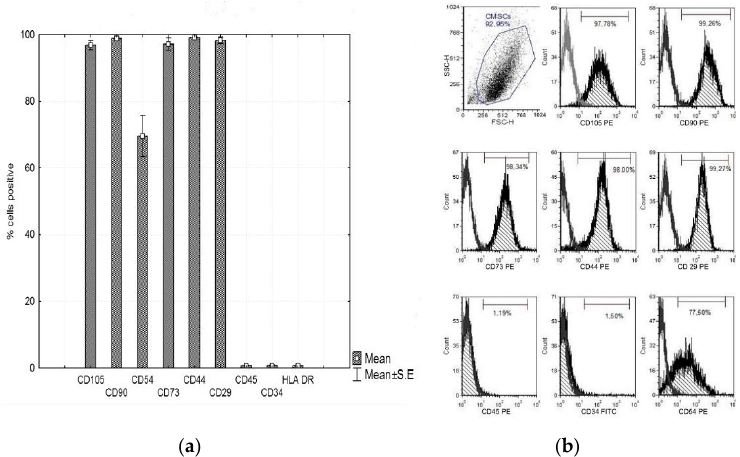
Figure 3. ( a ) Phenotype expression of mesenchymal and haematopoietic markers of CMSCs at passage 1, CD105 + , CD90 + , CD73 + , CD29 + , CD44 + , CD54 + , CD45 − , and CD34 − . Histograms represent mean ± S.E of seven independent experiments and ( b ) representative flow cytometry analysis for CMSCs at passage